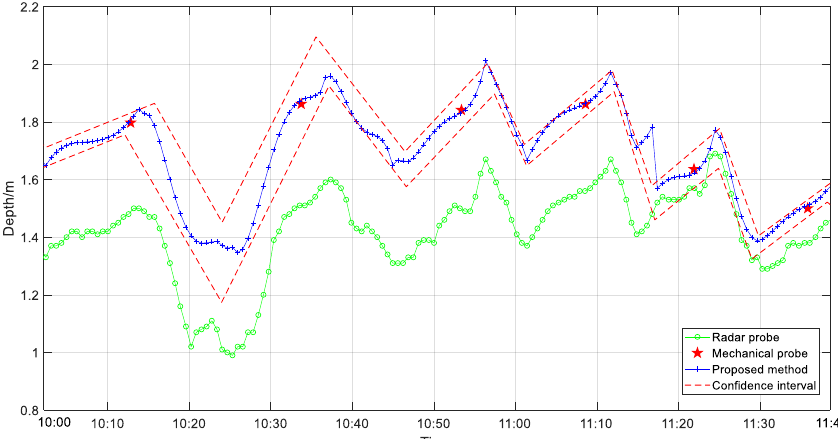
Figure 17. Depth of burden surface as determined using traditional methods.